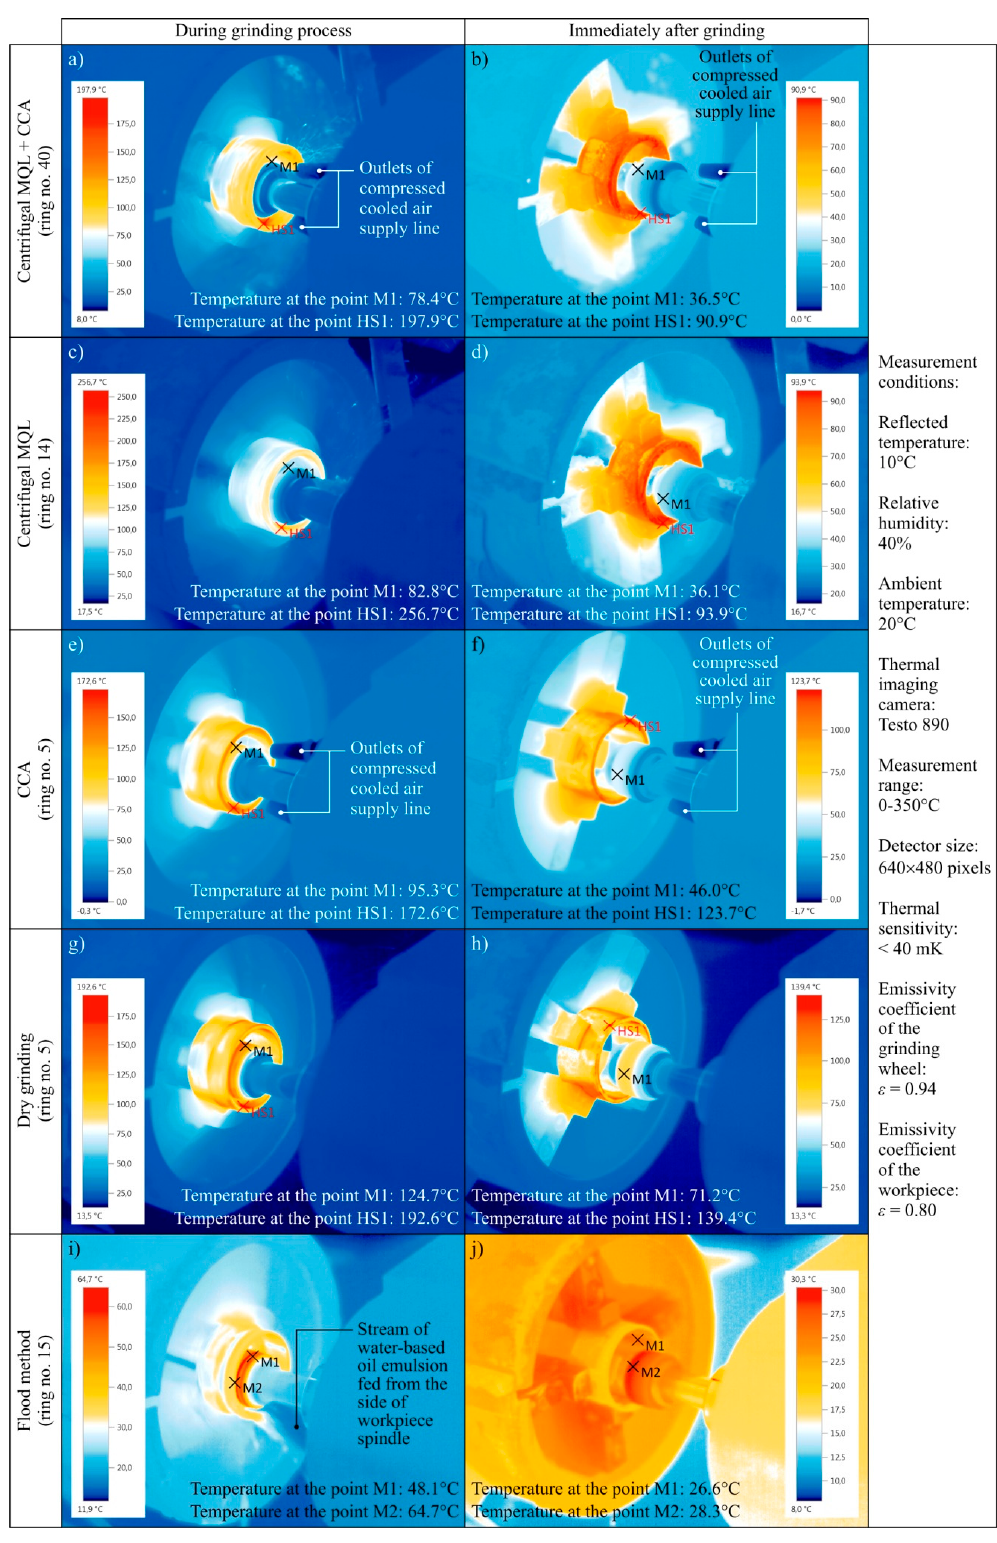
Figure 4. Thermograms recorded during ( a , c , e , g , i ) and immediately after grinding ( b , d , f , h , j ) of the last workpiece from the grinding wheel service life: ( a , b ) hybrid method of cooling and lubrication (centrifugal MQL + CCA); ( c , d ) centrifugal MQL; ( e , f ) CCA; ( g , h ) dry grinding; ( i , j ) flood method.